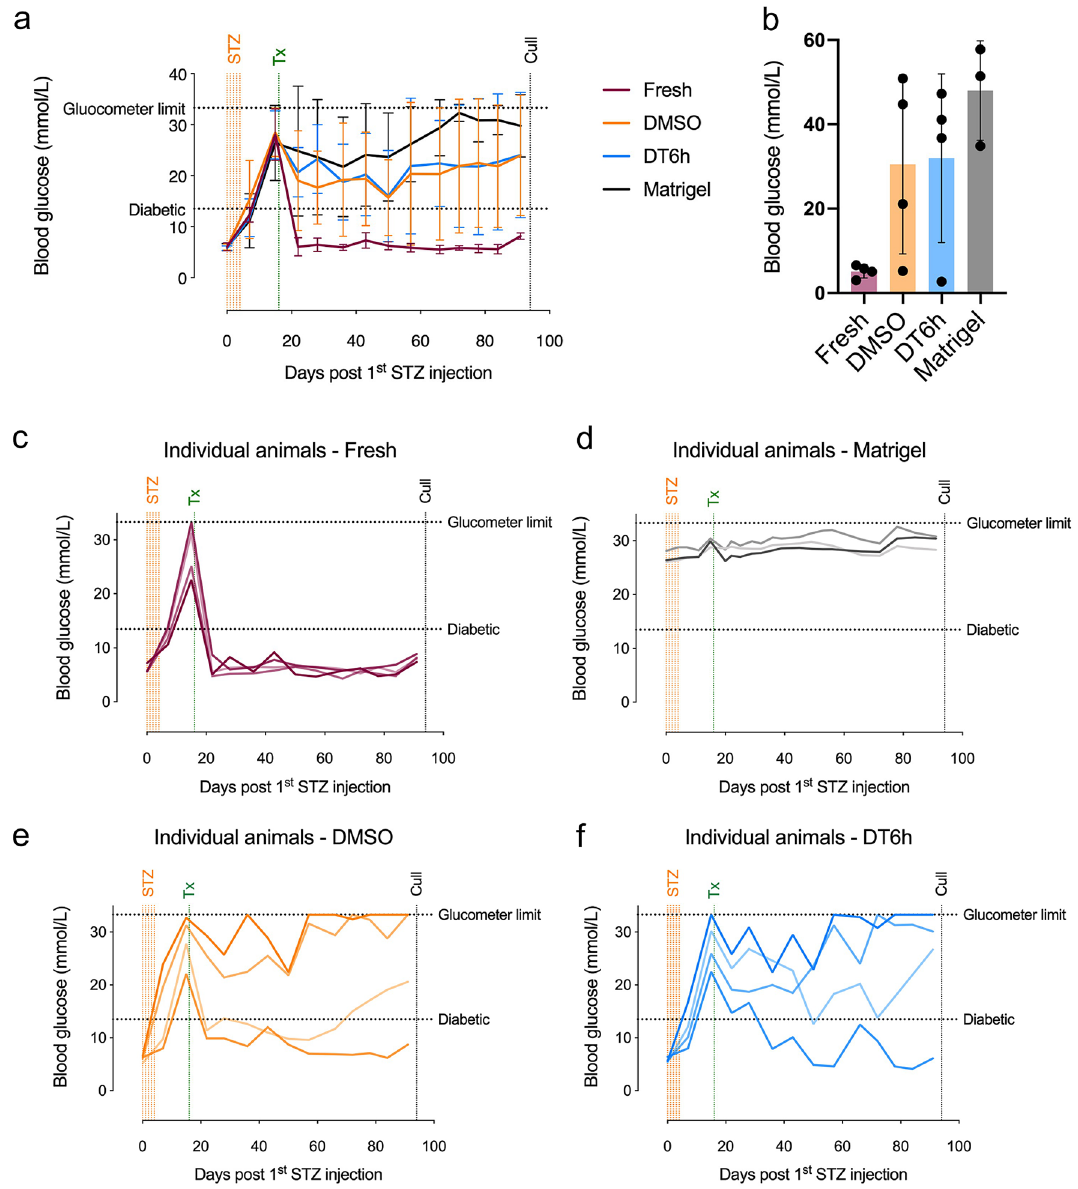
Figure 8. Engraftment of cryopreserved islets in STZ-induced diabetes mouse model. ( a ) Fasting blood glucose measurements in diabetic mice transplanted with 800 fresh, DMSO-cryopreserved or DT6h-cryopreserved islets or vehicle (Matrigel), measured using portable glucose meter (n = 3–4 mice). ( b ) Fasting blood serum glucose measured using an immunoassay on day 75 days after transplantation (day 91 after first STZ injection). ( c – f ) Fasting blood glucose in individual diabetic mice transplanted with ( c ) 800 fresh islets, ( d ) Matrigel/vehicle only, ( e ) 800 DMSO-cryopreserved islets and ( f ) 800 DT6h-cryopreserved islets over the time course of the experiments. All plots were produced using GraphPad Prism (version 8.4.1, https:// www. graph pad. com). STZ streptozotocin, Tx